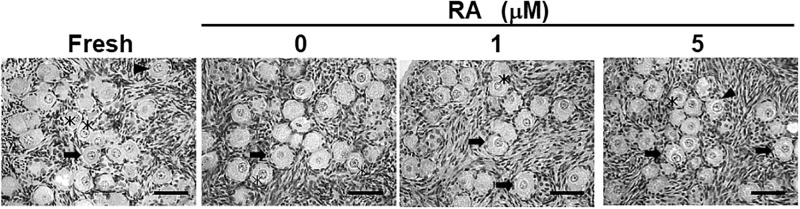
Histomicrographs of ovarian tissue cultured for 0 (fresh) and 7 d with RA.Bar = 50 μm. Asterisks indicate primordial follicles; arrows indicate the transition stage of primordial to primary follicle; arrow heads indicate primary follicles.